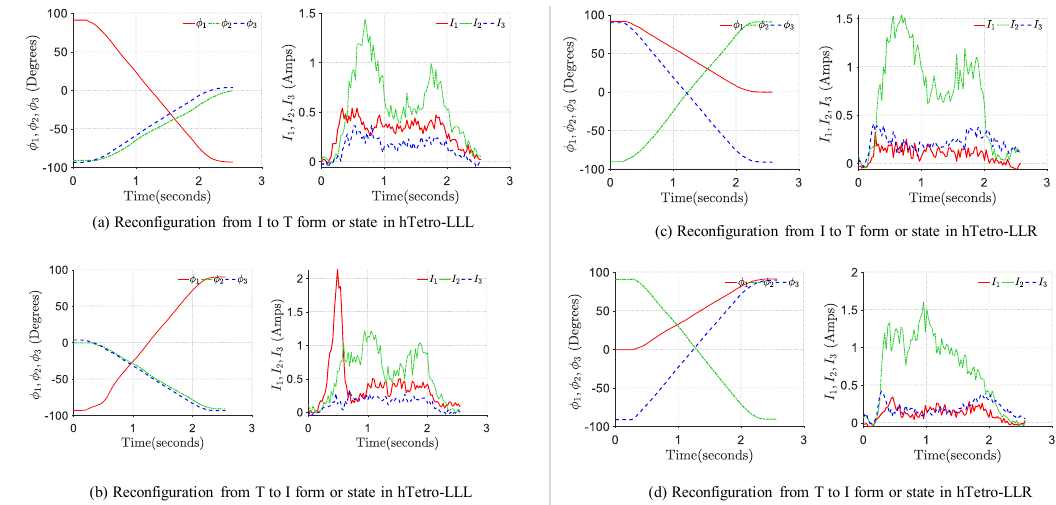
Figure 11. Angle and current variations for reconfiguration from I to T for hTetro-LLL and hTetro-LLR.